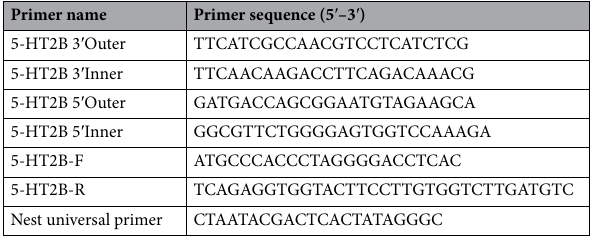
Table 2. Primers were used in cloning and characterizing the 5-HT2B